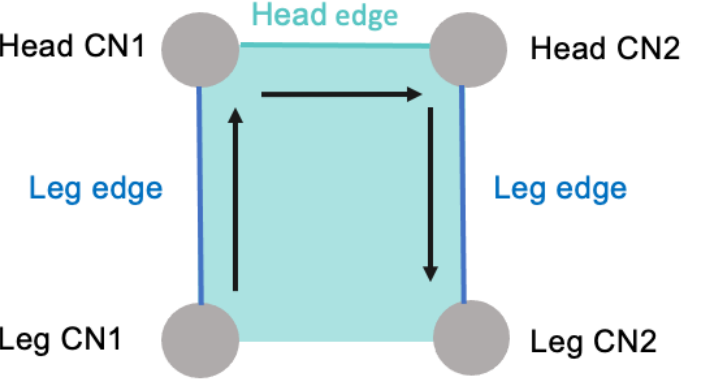
Figure 16. Single open loop consisting of four contact neighborhoods. Leg edges highlighted in blue and head edges are highlighted in